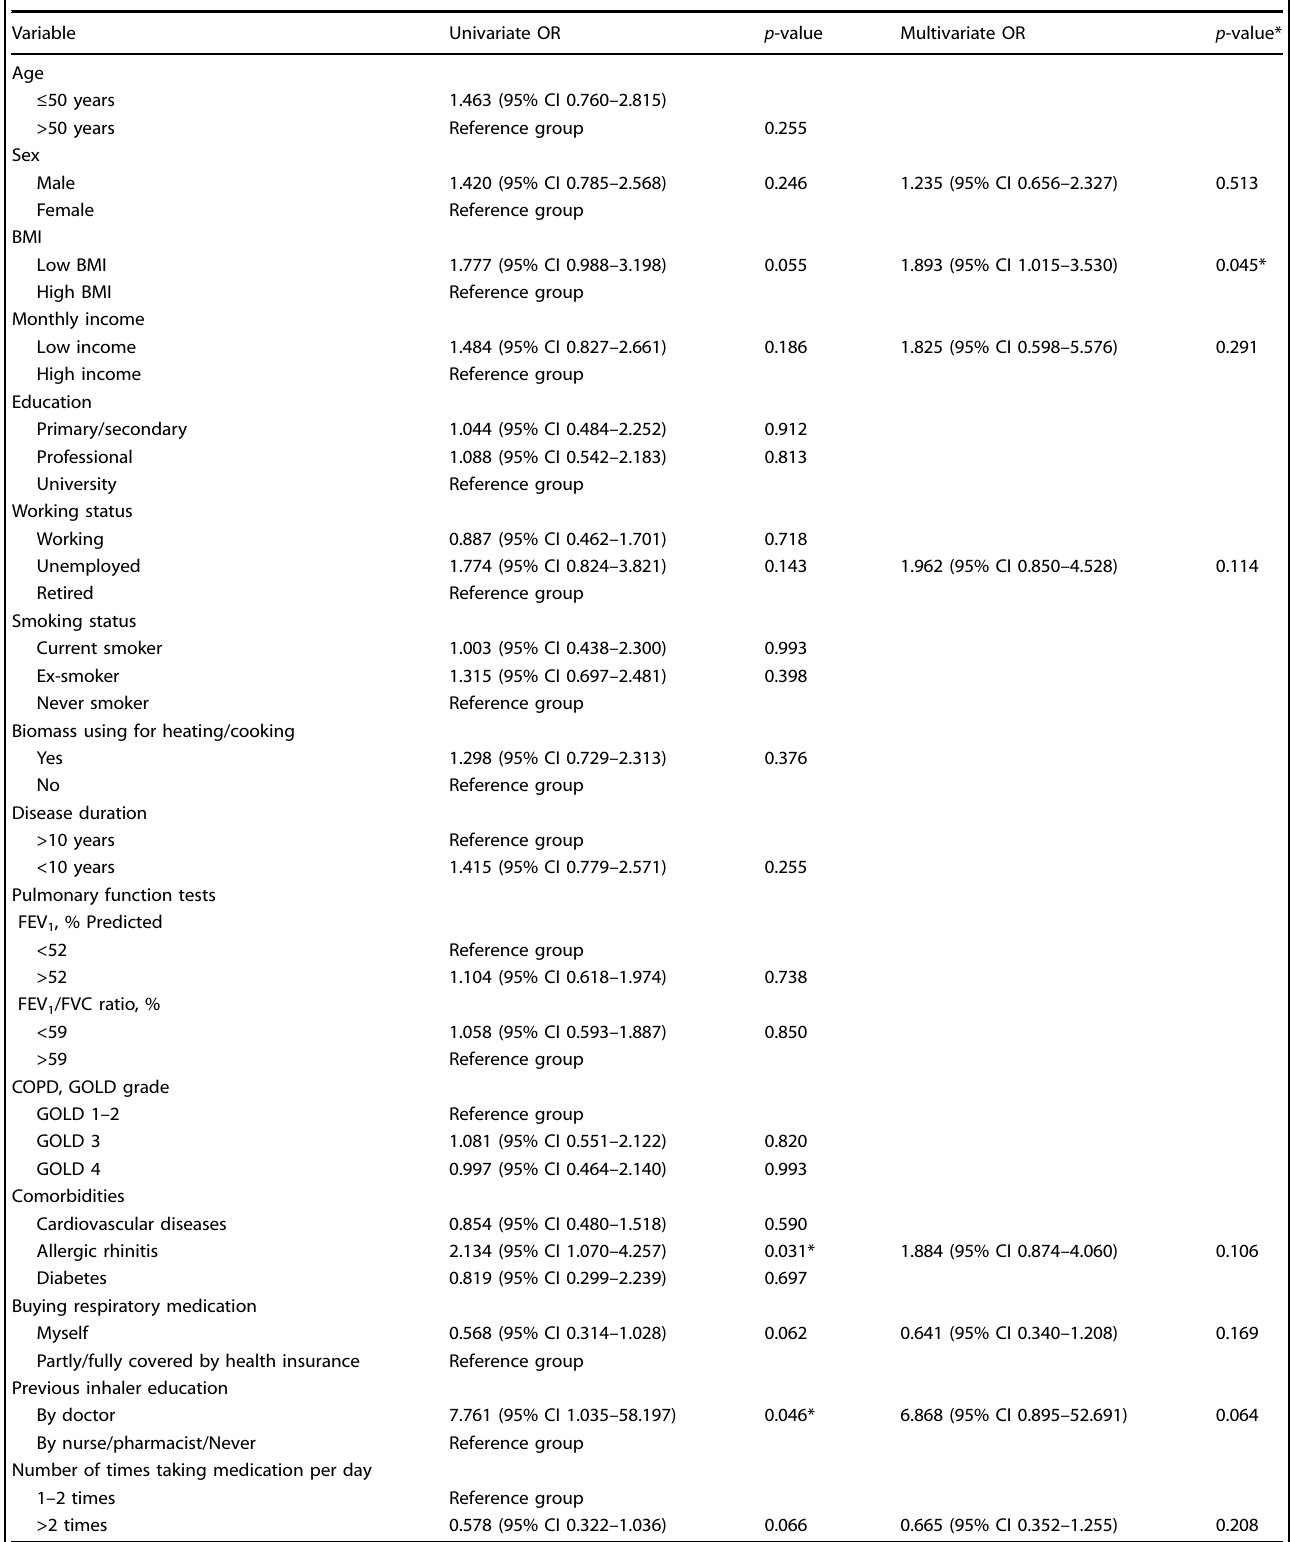
Table 4. Univariate and multivariate association with adherence in asthma and COPD patients ( n = 300).